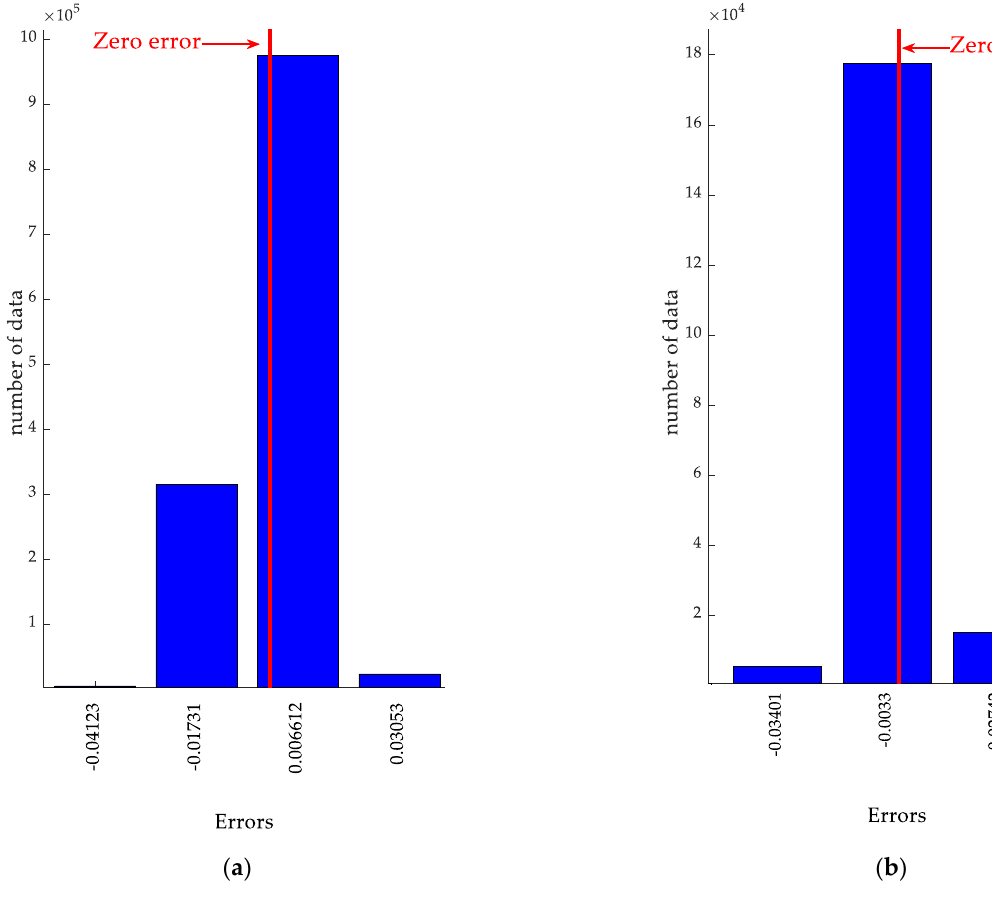
Figure 9. Error histogram for ( a ) training and ( b ) validation data testing.